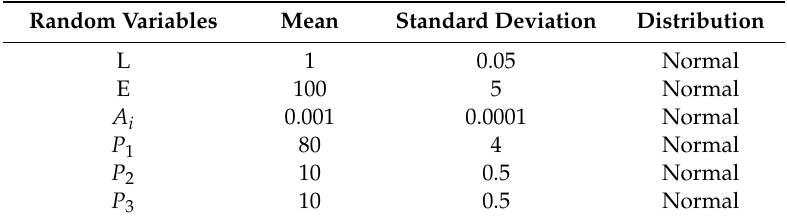
Table 6. Distribution information of the random variables of the truss structure.